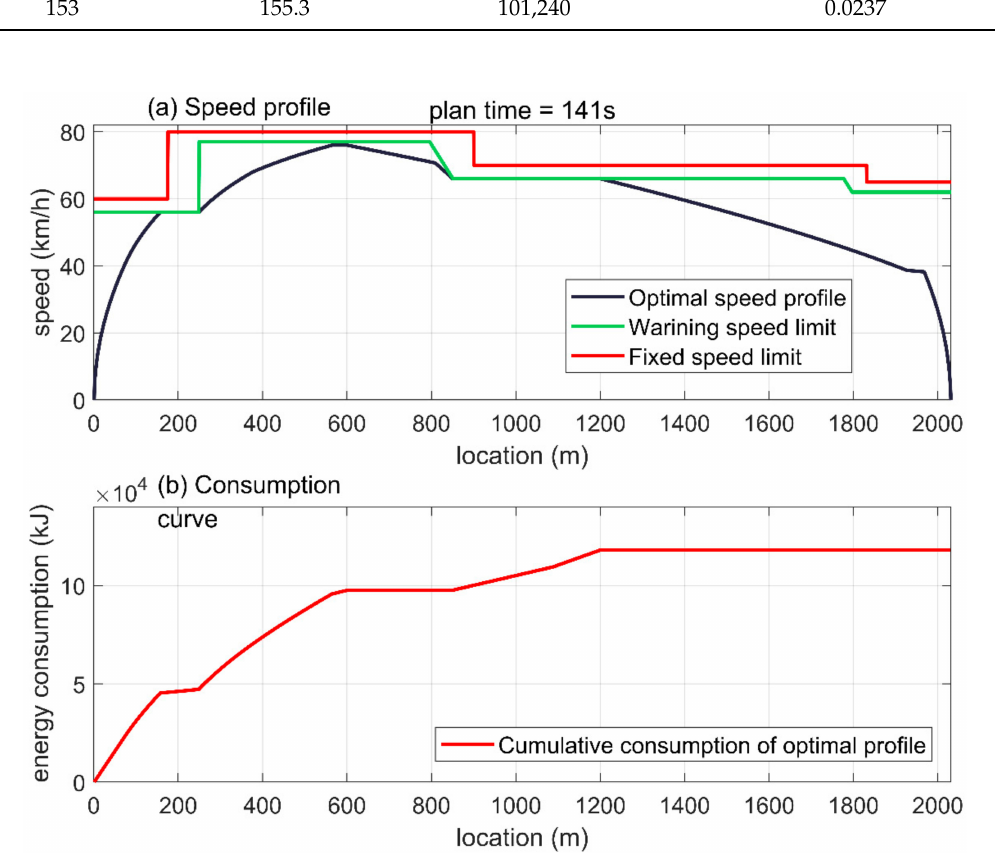
Figure 16. Optimal speed profile. ( a ) The optimal speed profile made by optimization; ( b ) Cumulative energy consumption growth